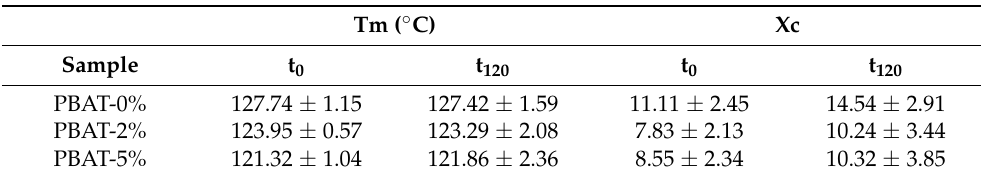
Table 1. Melting temperatures (Tm) and crystallinity (Xc) of PBAT and nanocomposite films, before and after soil burial degradation.